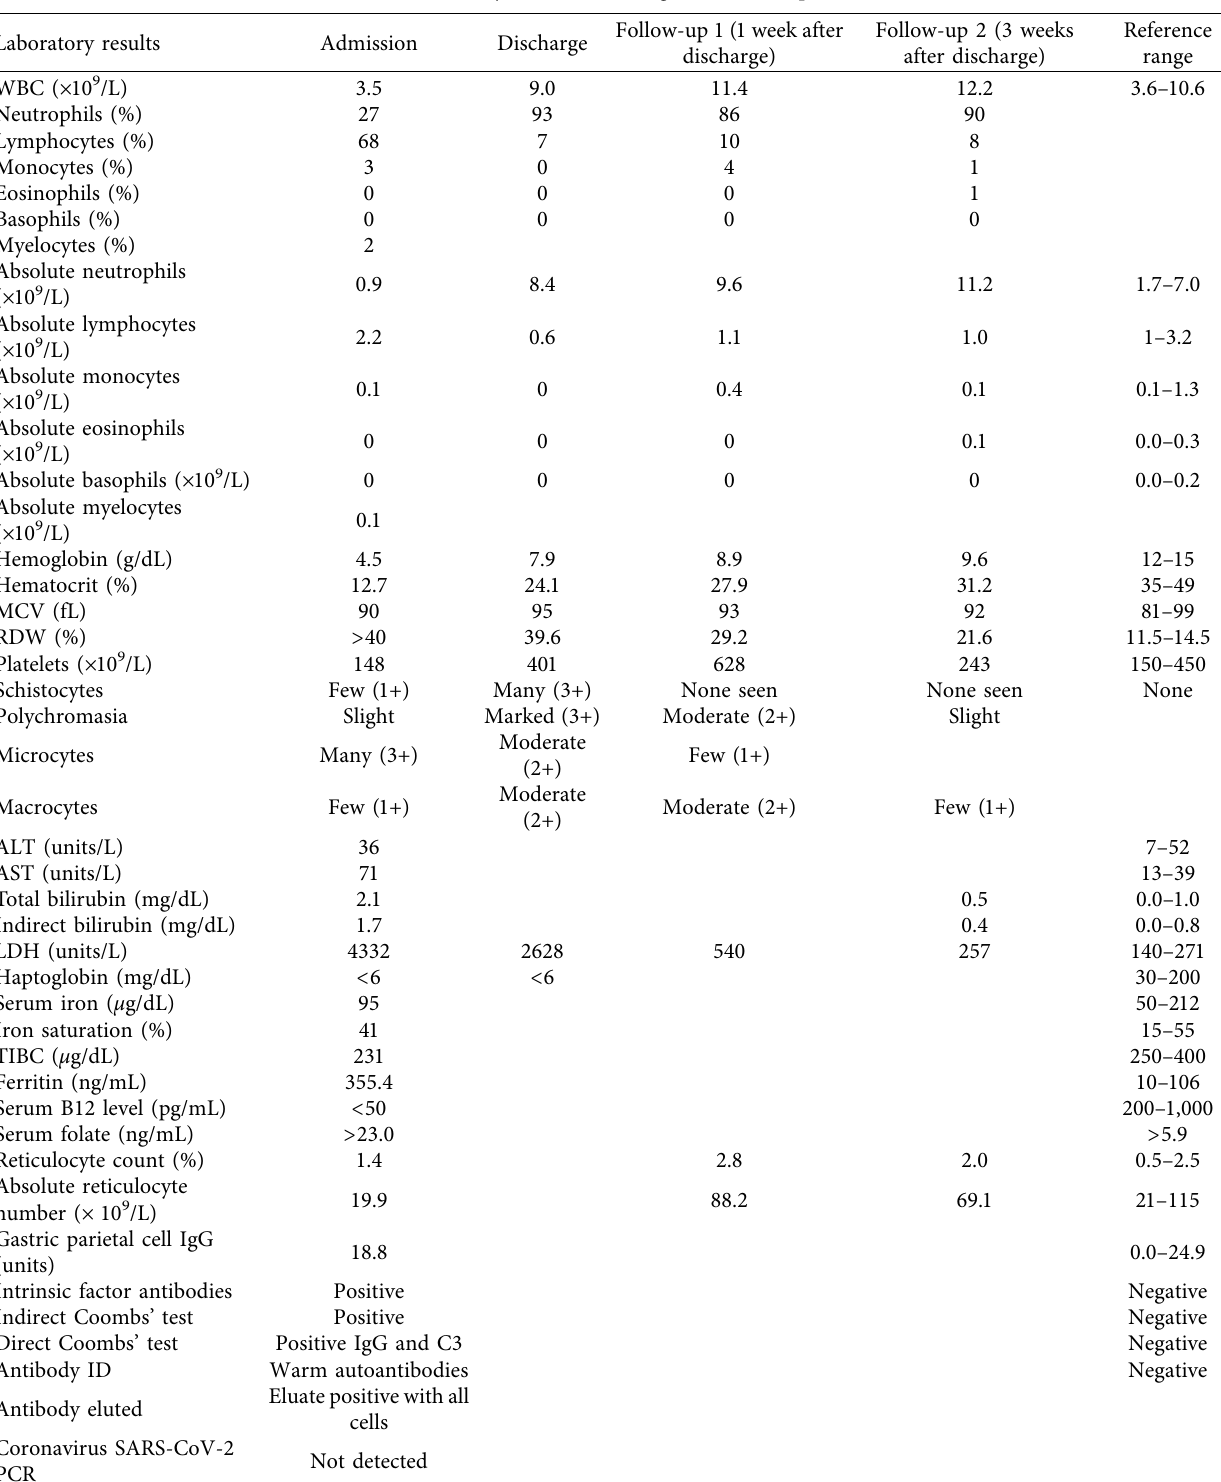
Table 1: Laboratory test result during and after